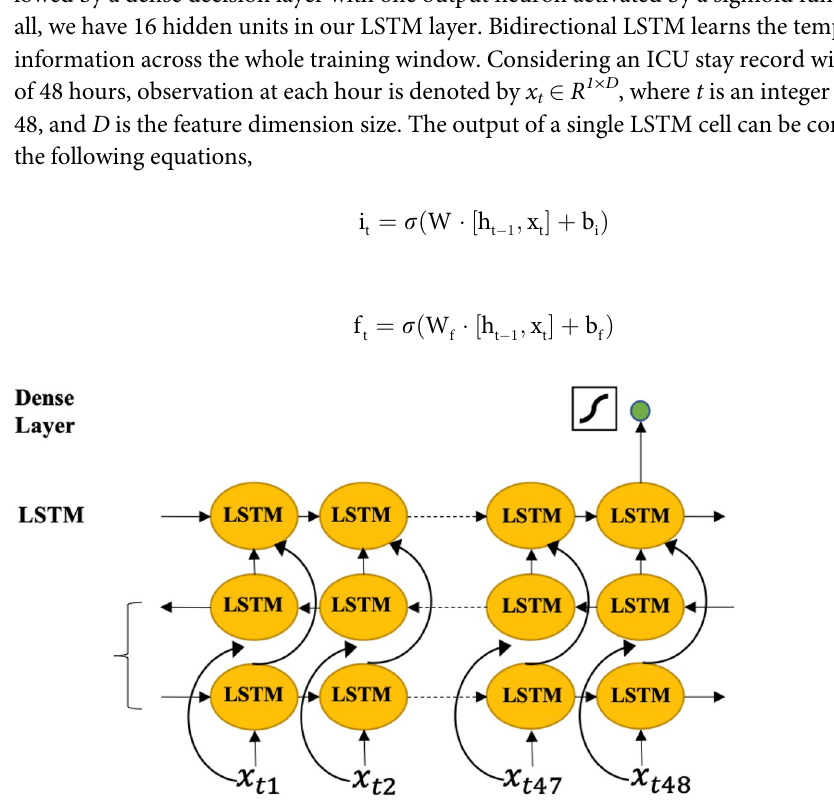
Fig 4. LSTM model. A bidirectional LSTM combined with an additional LSTM layer, followed by a dense decision layer with one output neuron activated by a sigmoid function. Overall, we have 16 hidden units in our LSTM layer.